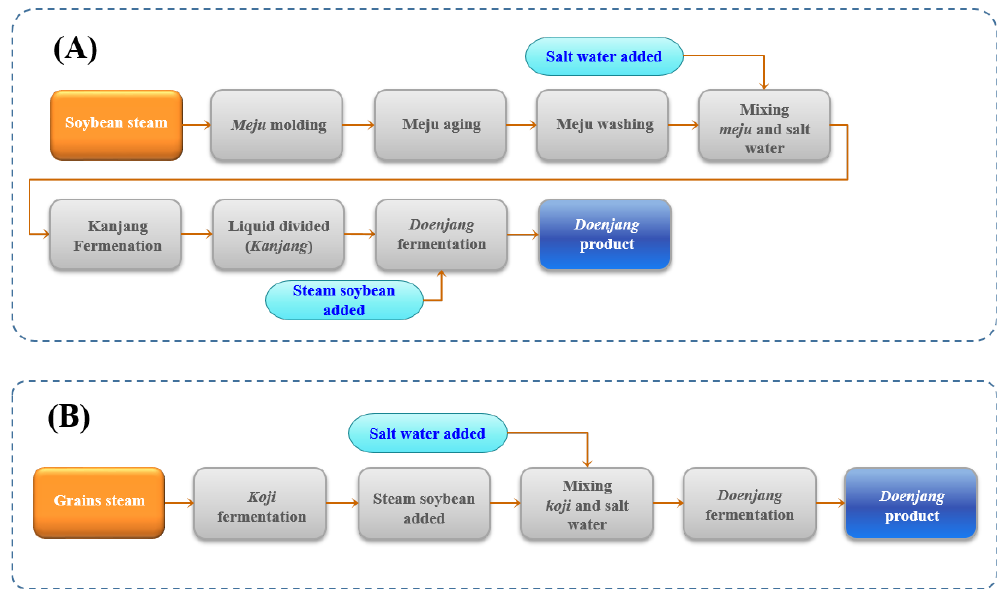
Figure 8. Manufacturing process of household ( A ) and commercial ( B ) doenjang . 3.3. Determination of pH, Acidity, Salinity and Soluble Protein Content on Doenjang The doenjang (10 g) was mixed with 90 mL distilled water and shaken for 30 min. Next, the supernatant was obtained by centrifugation (13,000× g , 3 min). The supernatant’s